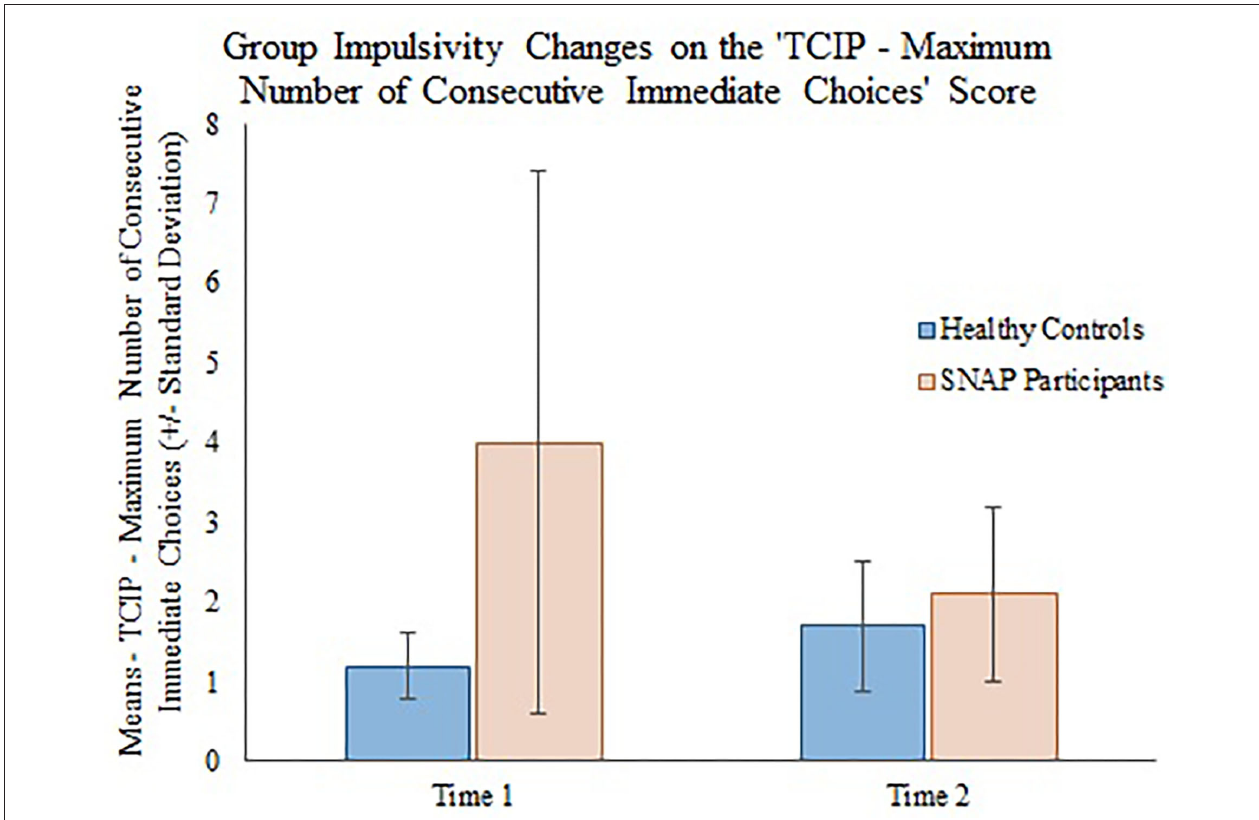
FIGURE 3 | Group impulsivity changes on the Two Choice Impulsivity Paradigm–Maximum Number of Consecutive Immediate Choices